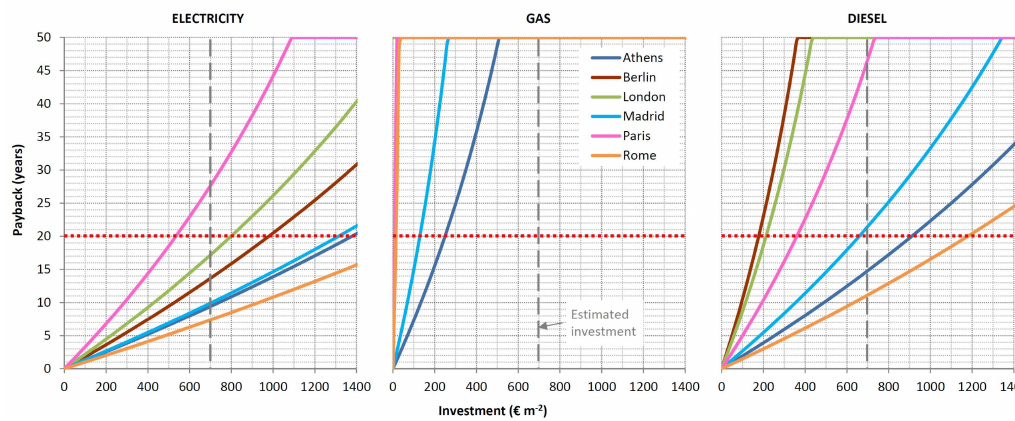
Figure 8. Payback variations produced by changes in the necessary investment.